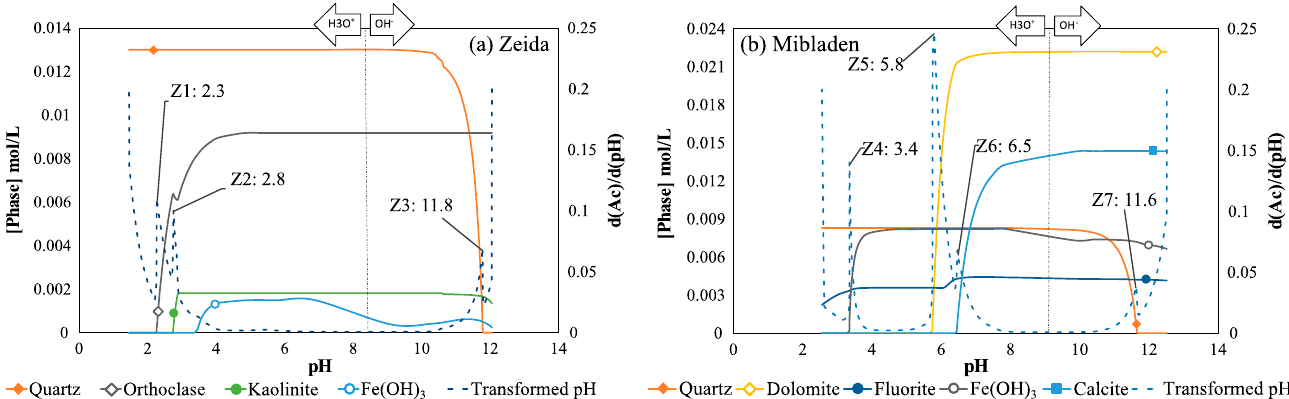
Figure 3. Transformed curve (d Eq_H + /d pH = d(Ac)/d(pH), right axis) as a function of pH obtained from observations, along with modeled compositions of mineral phases (left axis), in the Zeida ( a ) and Mibladen ( b ) mining waste.